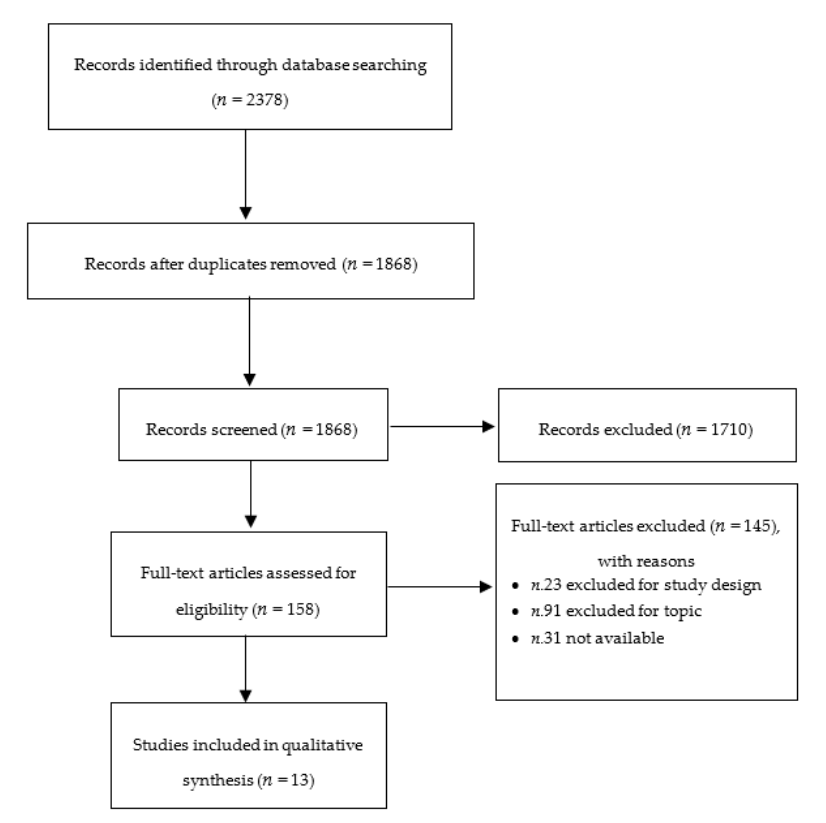
Figure 1. Flow chart of the literature selection. Table 1. PICOS criteria (participants, interventions, comparisons, outcomes, and study design) used to define the research question.